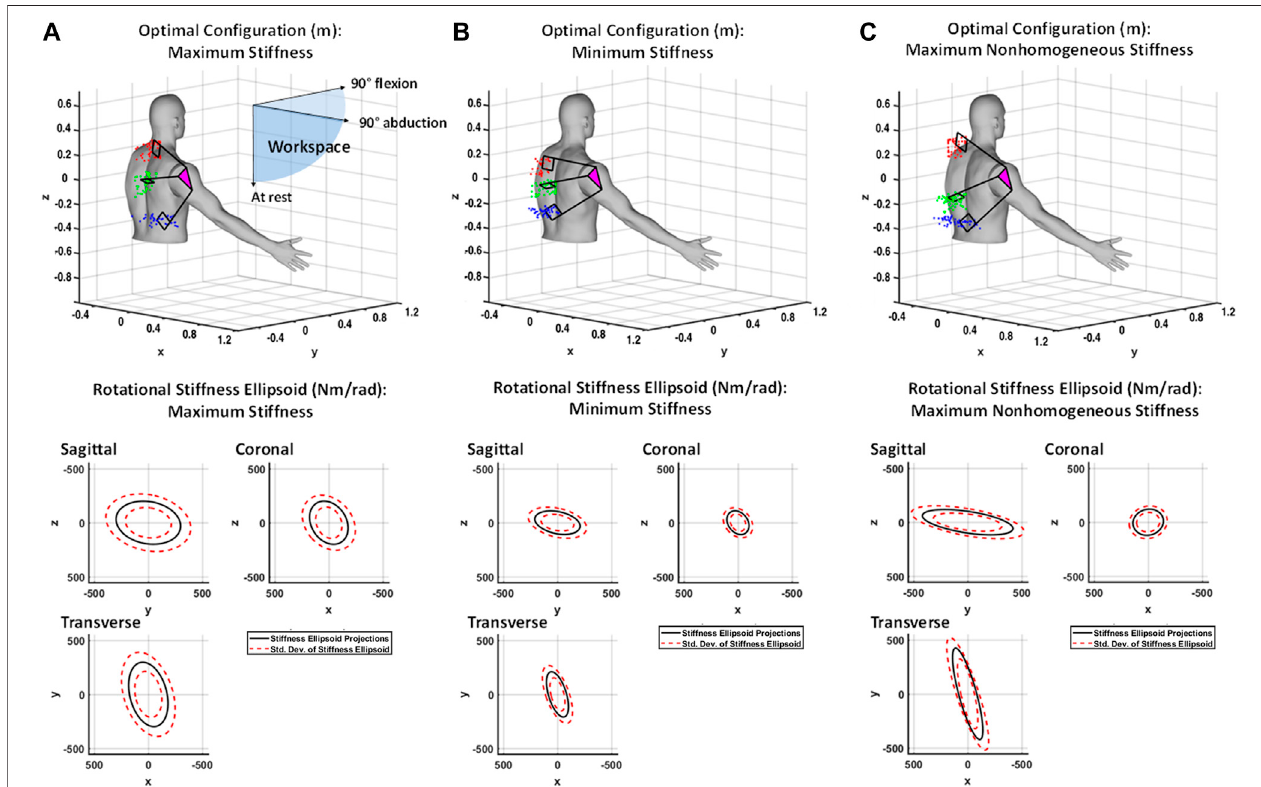
FIGURE 7 | Orientation of the shoulder exoskeleton along with projections of the associated theoretical rotational stiffness ellipsoid (Nm/rad) shown in black. The roll, pitch and yaw stiffness measurements are shown in red for contrast. The origin of the frame is at the center-of-rotation of the human shoulder.